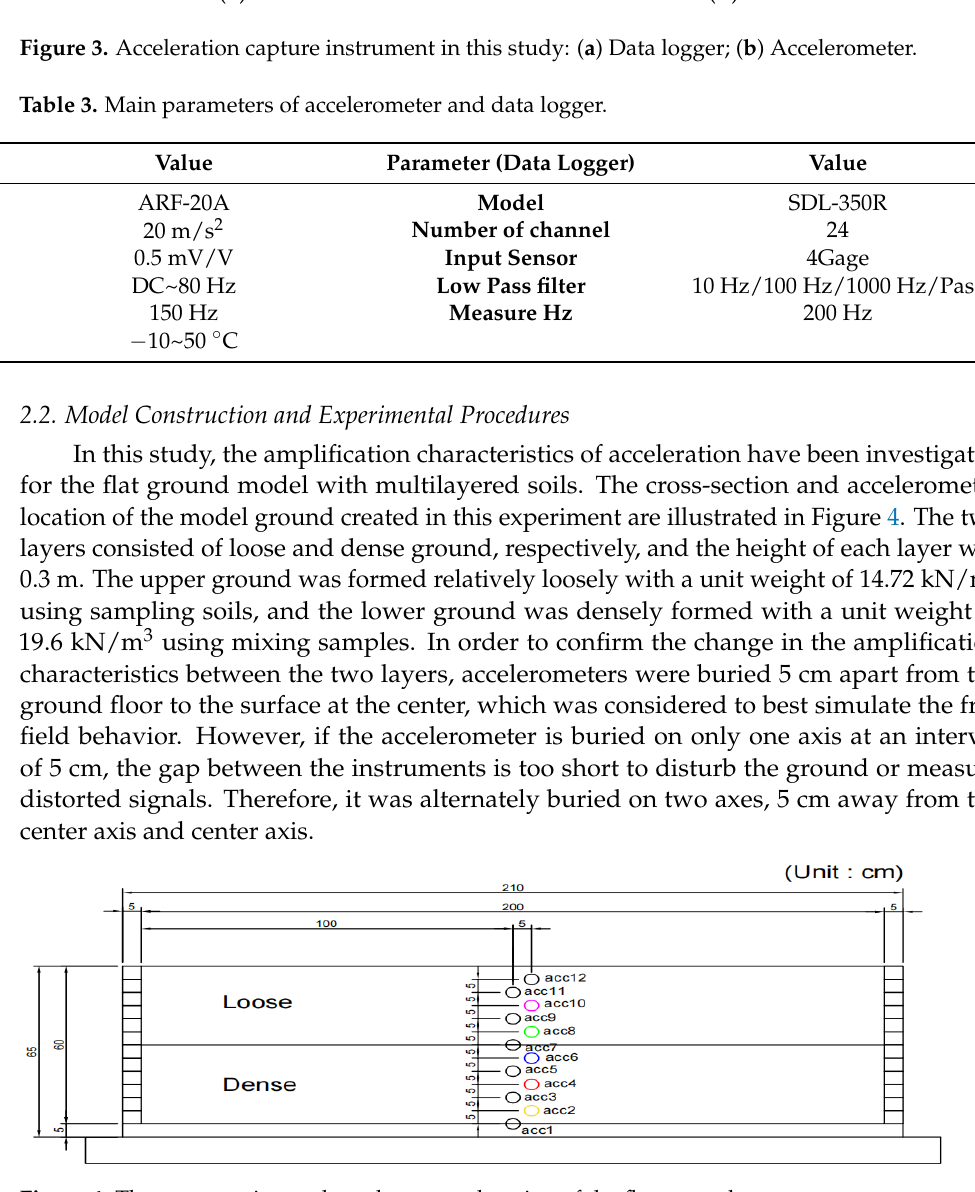
( b ) ( c ) Figure 5. Time-histories of the input ground motions used in this study: ( a ) artificial earthquake wave; ( b ) sine sweep wave; ( c ) sine 10 Hz wave. 3. Multilayered Flat Model Ground Test Results and Analysis 3.1. Shear Wave Velocity The shear wave velocity is usually used to characterize the dynamic property of soil in geotechnical engineering, and the importance of shear wave velocity in geotechnical seismic engineering has been widely recognized and applied in seismic design and seis- mic performance evaluation [14]. The average shear wave velocity of the model was ob- tained by substituting the difference between the distance between the two accelerometers buried in the ground and the arrival time of the shock wave into the velocity formula by